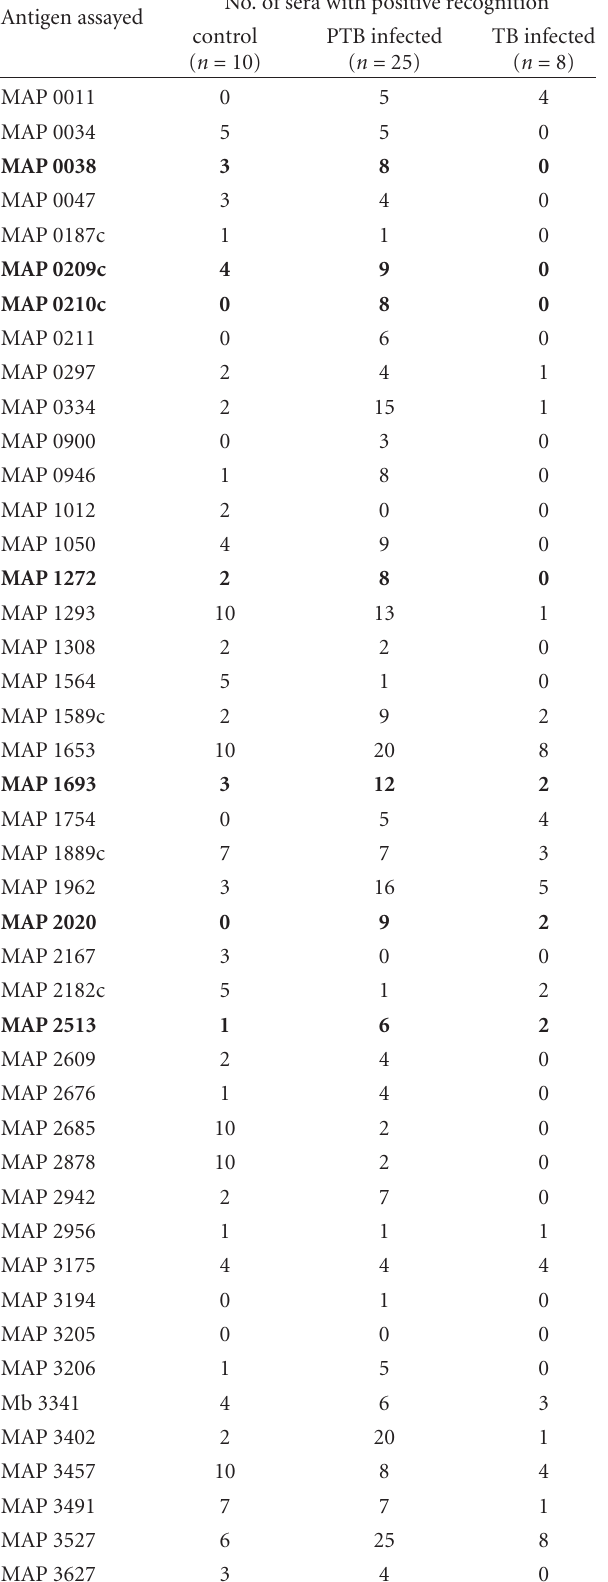
Table 3: Reactivity of bovine sera to the panel of selected antigens from MAP.